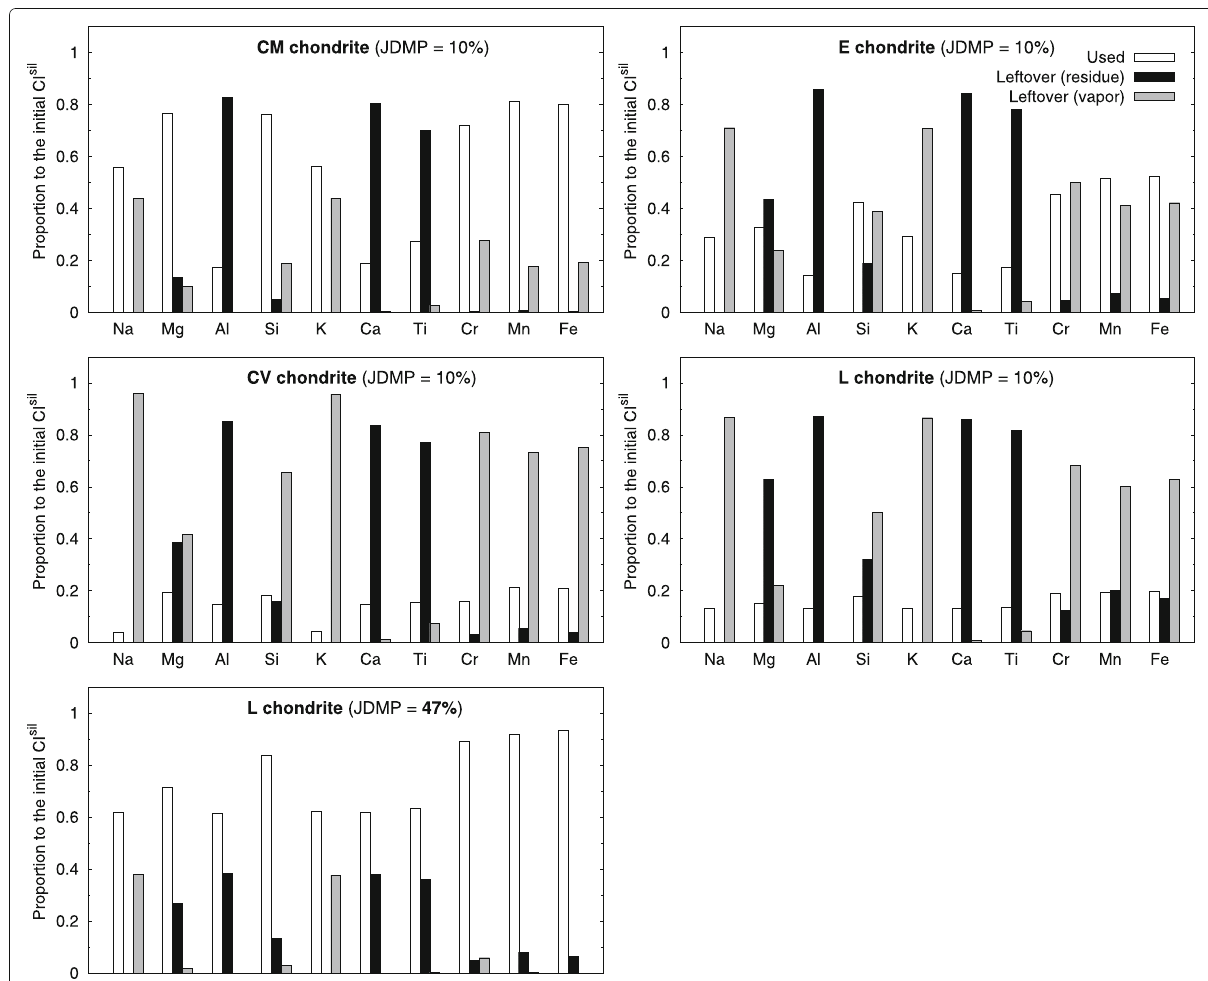
Fig. 9 Proportions of each of the ten elements relative to its initial abundance in CI sil , which reside in (A-1) the chondrite forming material (a total of F 1 through F 4 ), (A-2) the leftover residue of MLB that is not used in forming chondrules, and (A-3) the leftover vapor (or condensates) that is also not used in chondrule formation. Used: A-1 component. Leftover (residue): A-2 component. Leftover (vapor): A-3 component. JDMP: jet-droplet mass